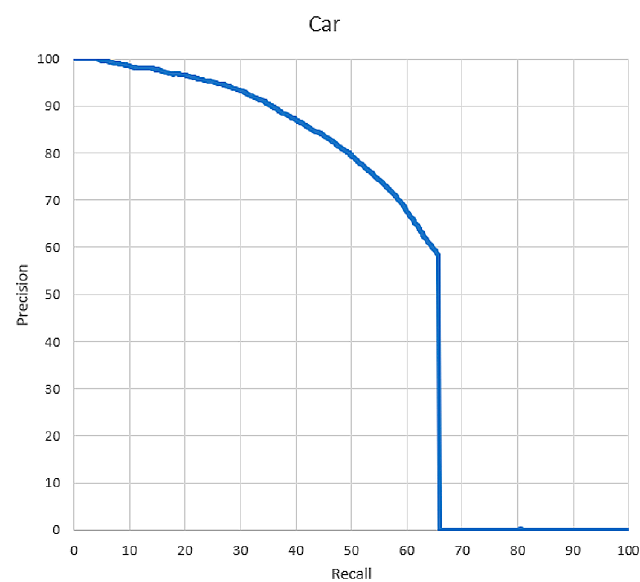
Figure 7. The precision-recall curve of our vehicle detection classifier. For a required recall, if our result can reach the recall, the corresponding precision can be calculated according to the measurement criteria in [23].